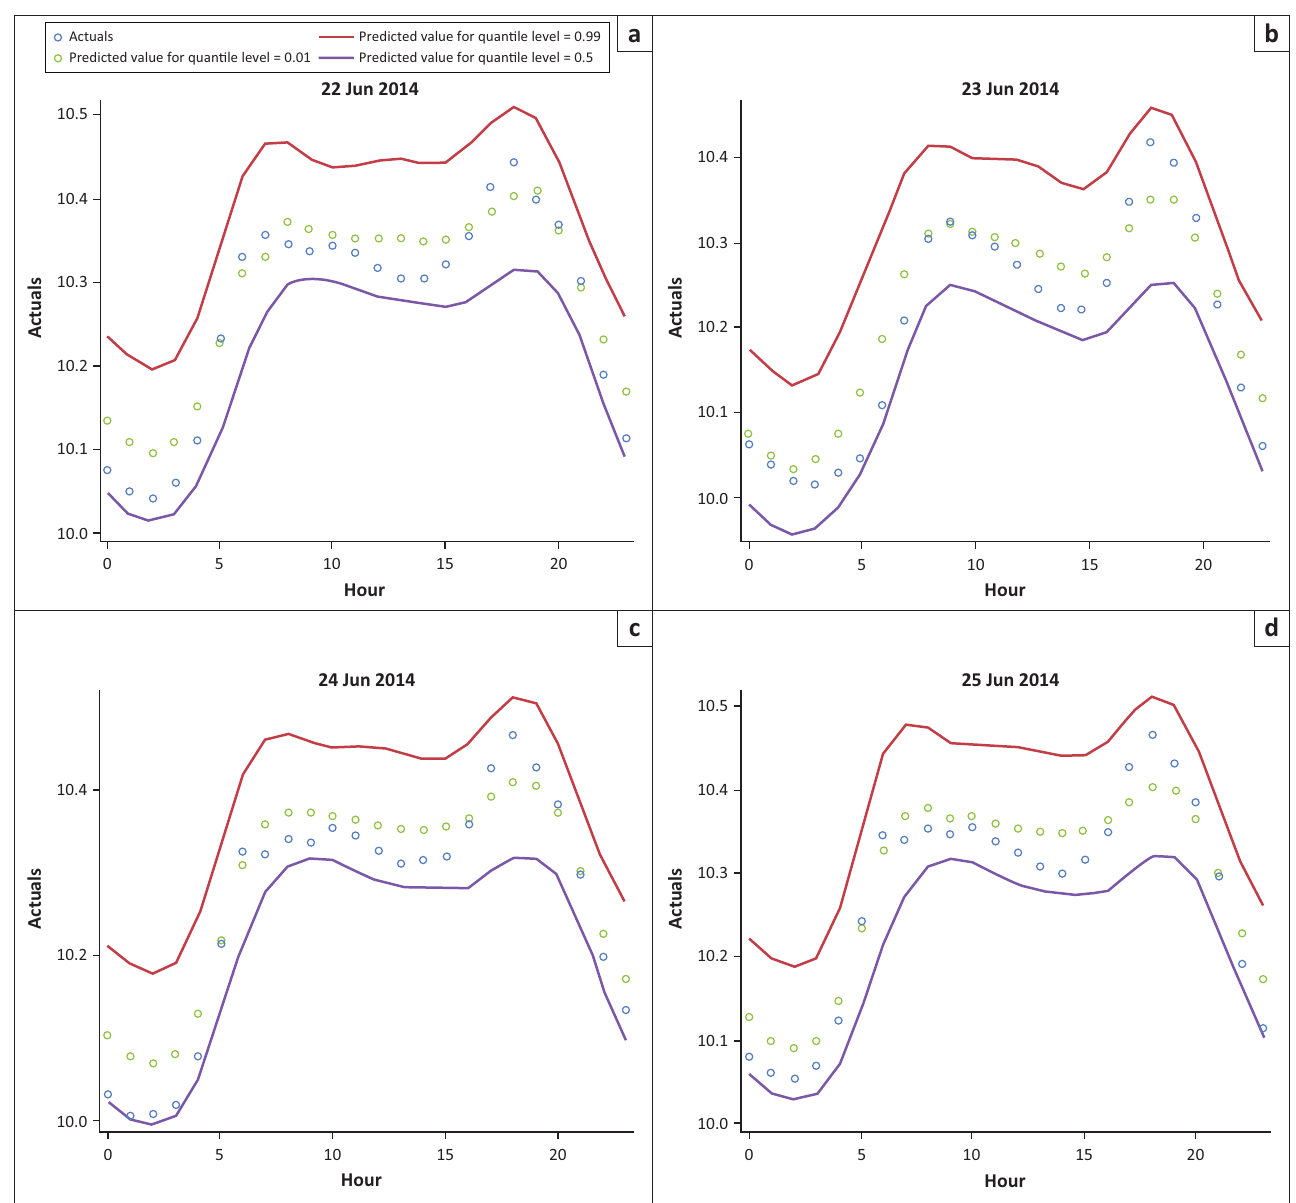
FIGURE 5: Distribution of forecasted daily electricity demand: (a) 22 June 2014, (b) 23 June 2014, (c) 24 June 2014, (d) 25 June